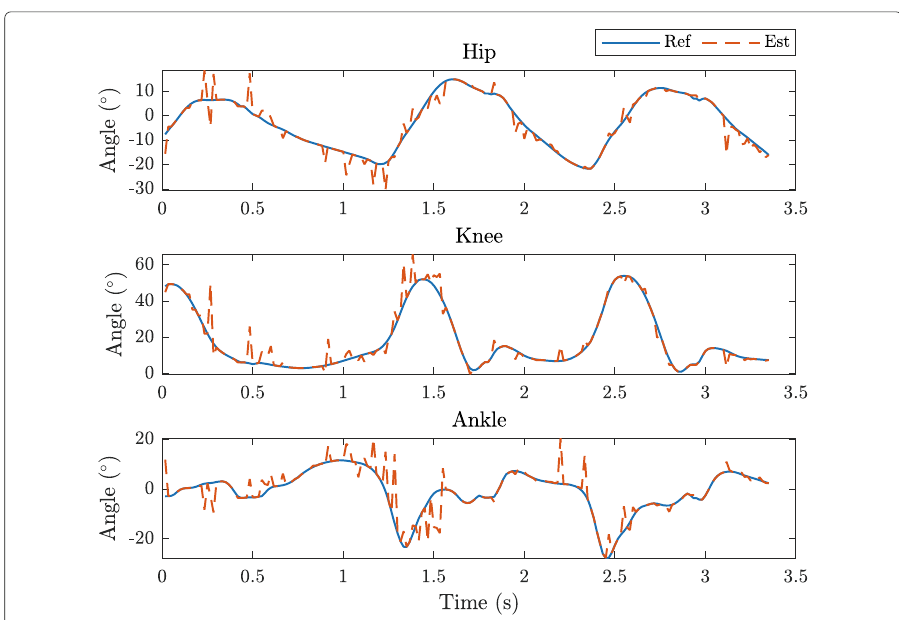
Fig. 9 Estimated lower limb joint angles in the sagittal plane using the GRNN with input set 4 and the reference lower limb joint angles from the wearable system. Blue solid lines and red dashed lines are the reference and the estimated joint angles,